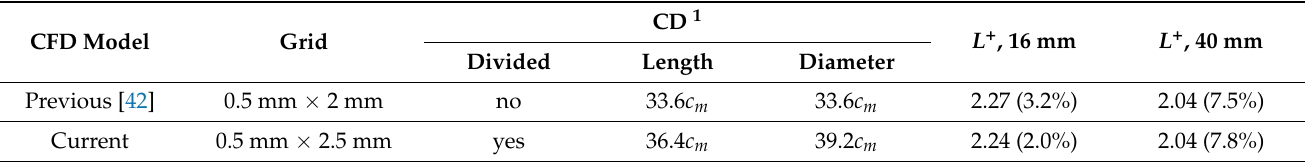
Table 1. Comparison between the previous and current CFD models.